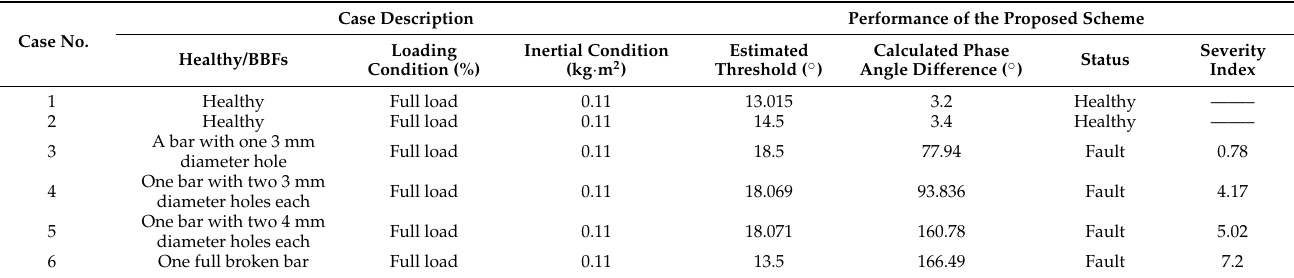
Table 4. Testing the proposed scheme using the experimental dataset.